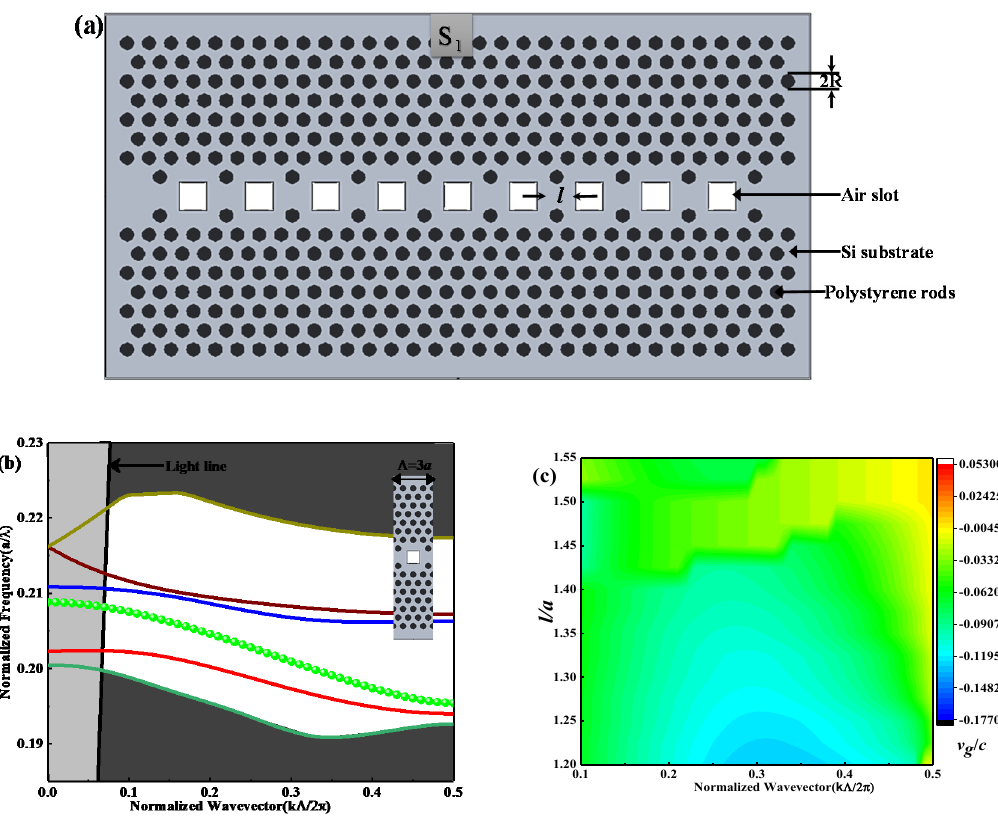
( a ) Schematic structure of the proposed S1 SP − CS − SPCW geometry based on triangular-lattice photonic crystal made up of holes filled with electro-optic polystyrene (refractive index n poly = 1.59) with basic hole radius R = 0.30 a in a silicon substrate of n si = 3.48; ( b ) the dispersion curve for TM with l = 1.30 a , where the inset shows the supercell used for simulation; ( c ) the normalized-group velocity ( v g / c ) contour map with l varying from 1.20 a to 1.55 a via normalized wavevector K .